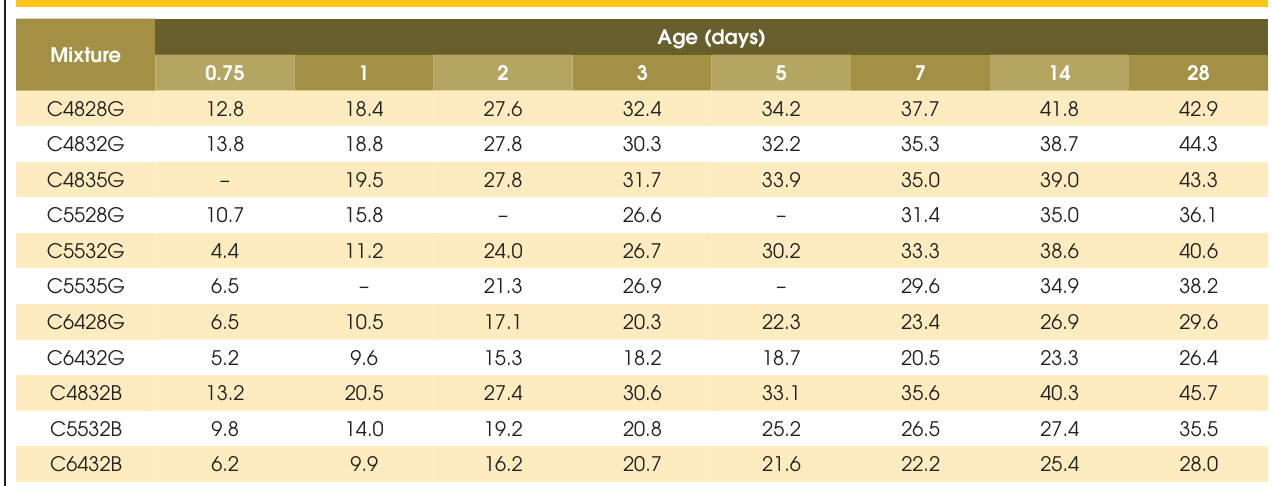
Figure 2 – Comparison among UPV values for concrete mixtures with w/c of